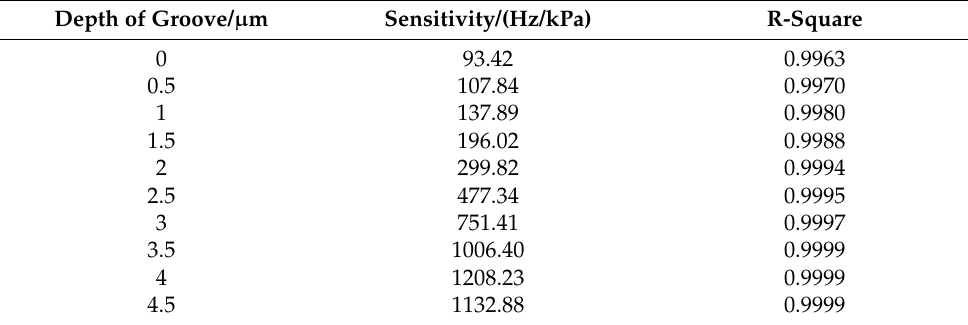
Table 2. Pressure sensitivity and linear fit of C3 with a single 2 µ m width